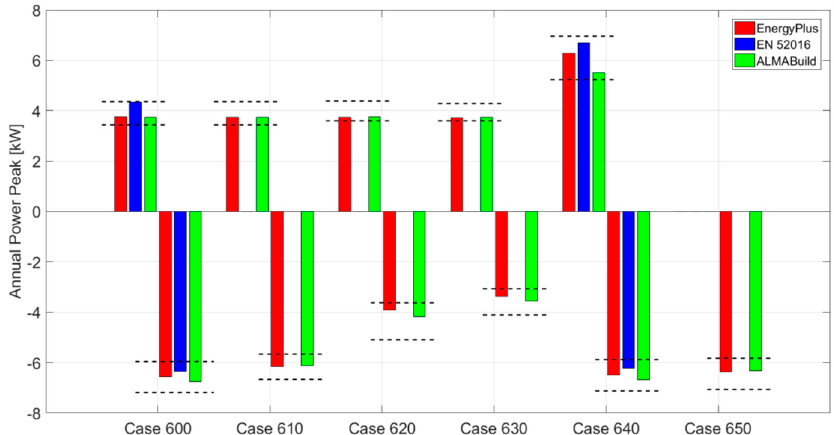
Figure 10. Comparison of the annual power peak (kW) predicted by EnergyPlus, the Standard EN 52016 and ALMABuild for lightweight BESTEST buildings.